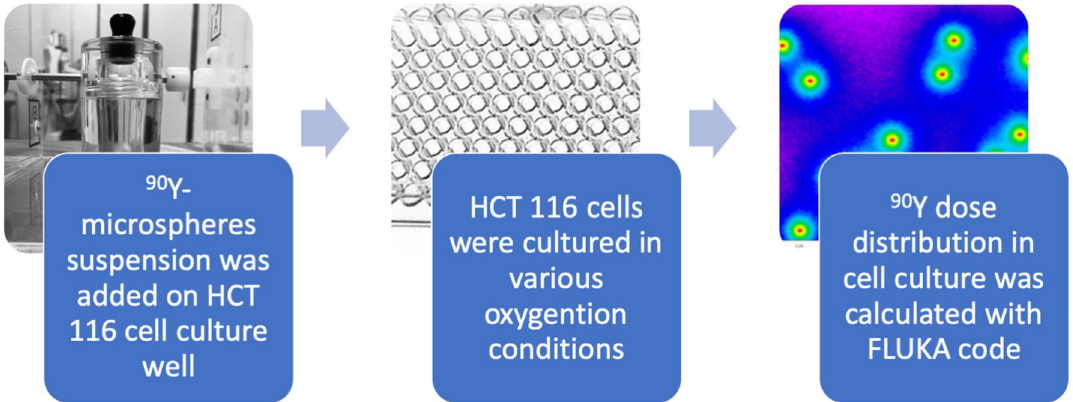
Figure 2. Conception of a novel in vitro model for SIRT. 90 Y microspheres were delivered in dedicated lead-glass vials (left image), transferred to HCT116 cell plates, which were cultured in various oxygenation conditions. FLUKA simulation software was used to calculate dose distribution across the plate well (right